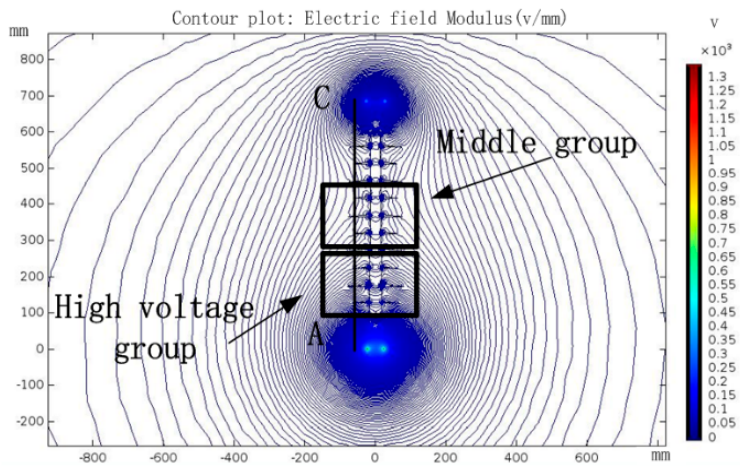
Figure 8. Contour line of the electric field around Type-A.